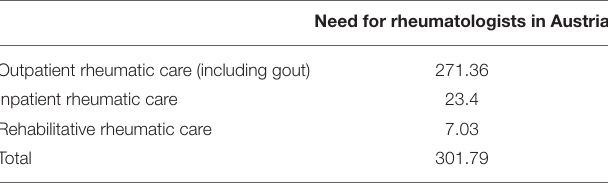
TABLE 5 | Total need of rheumatologists calculated for Austria with 7.03 million adult